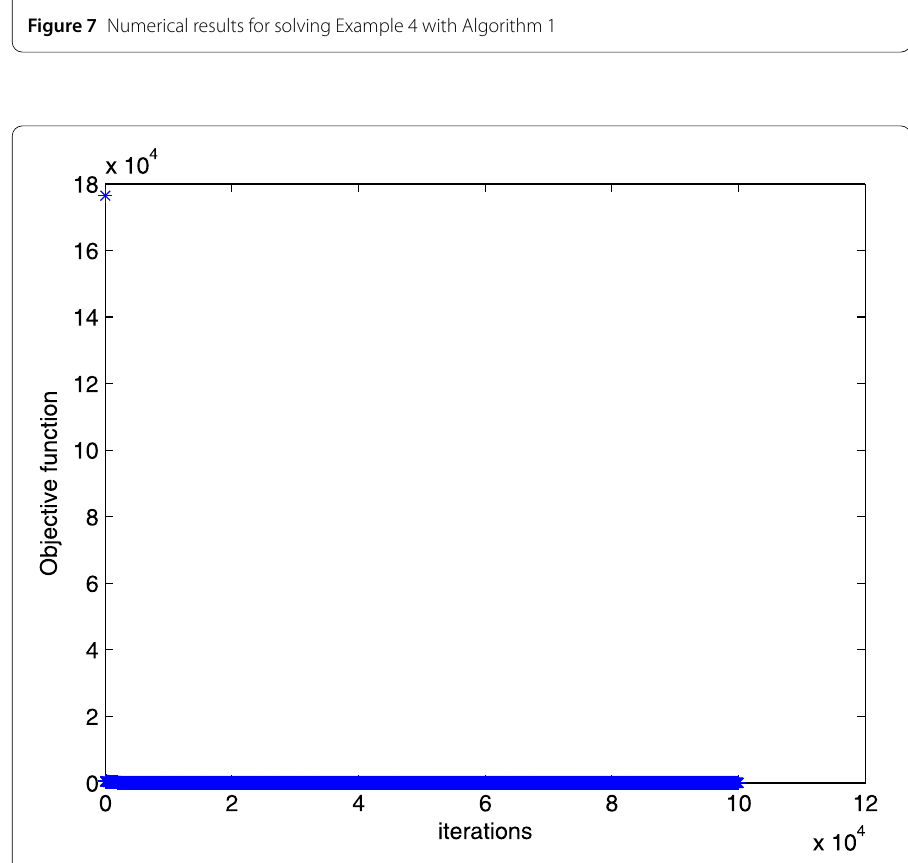
Figure 8 Numerical results for solving Example 4 with smoothing gradient